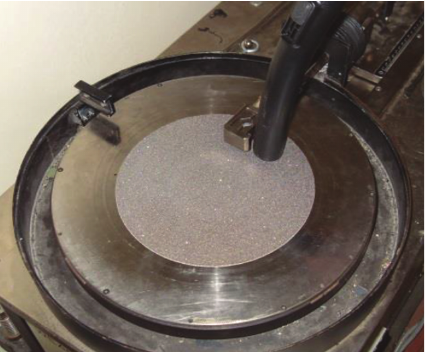
Figure 2: Abrasion